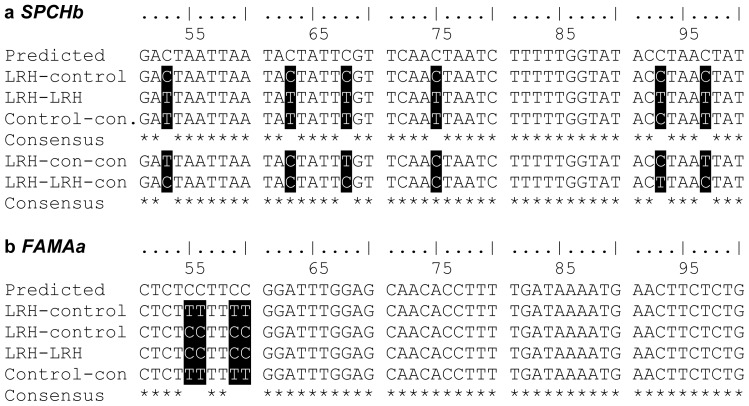
Example 50 bp fragments of (a) SPCHb and (b) FAMAa following bisulfite-sequencing of pooled sample DNA from progeny grown in the control and low relative humidity (LRH) treatment, parent-progeny. “Predicted” fragments are majority examples from the LRH-induced methylated parents. Differential methylation with progeny treatment is highlighted. When unmethylated, a bisulfite-sequenced “C” will convert to “T”. Two examples are shown for FAMAa control-grown progeny, where both methylated and unmethylated cytosines were found, to illustrate the contrast.